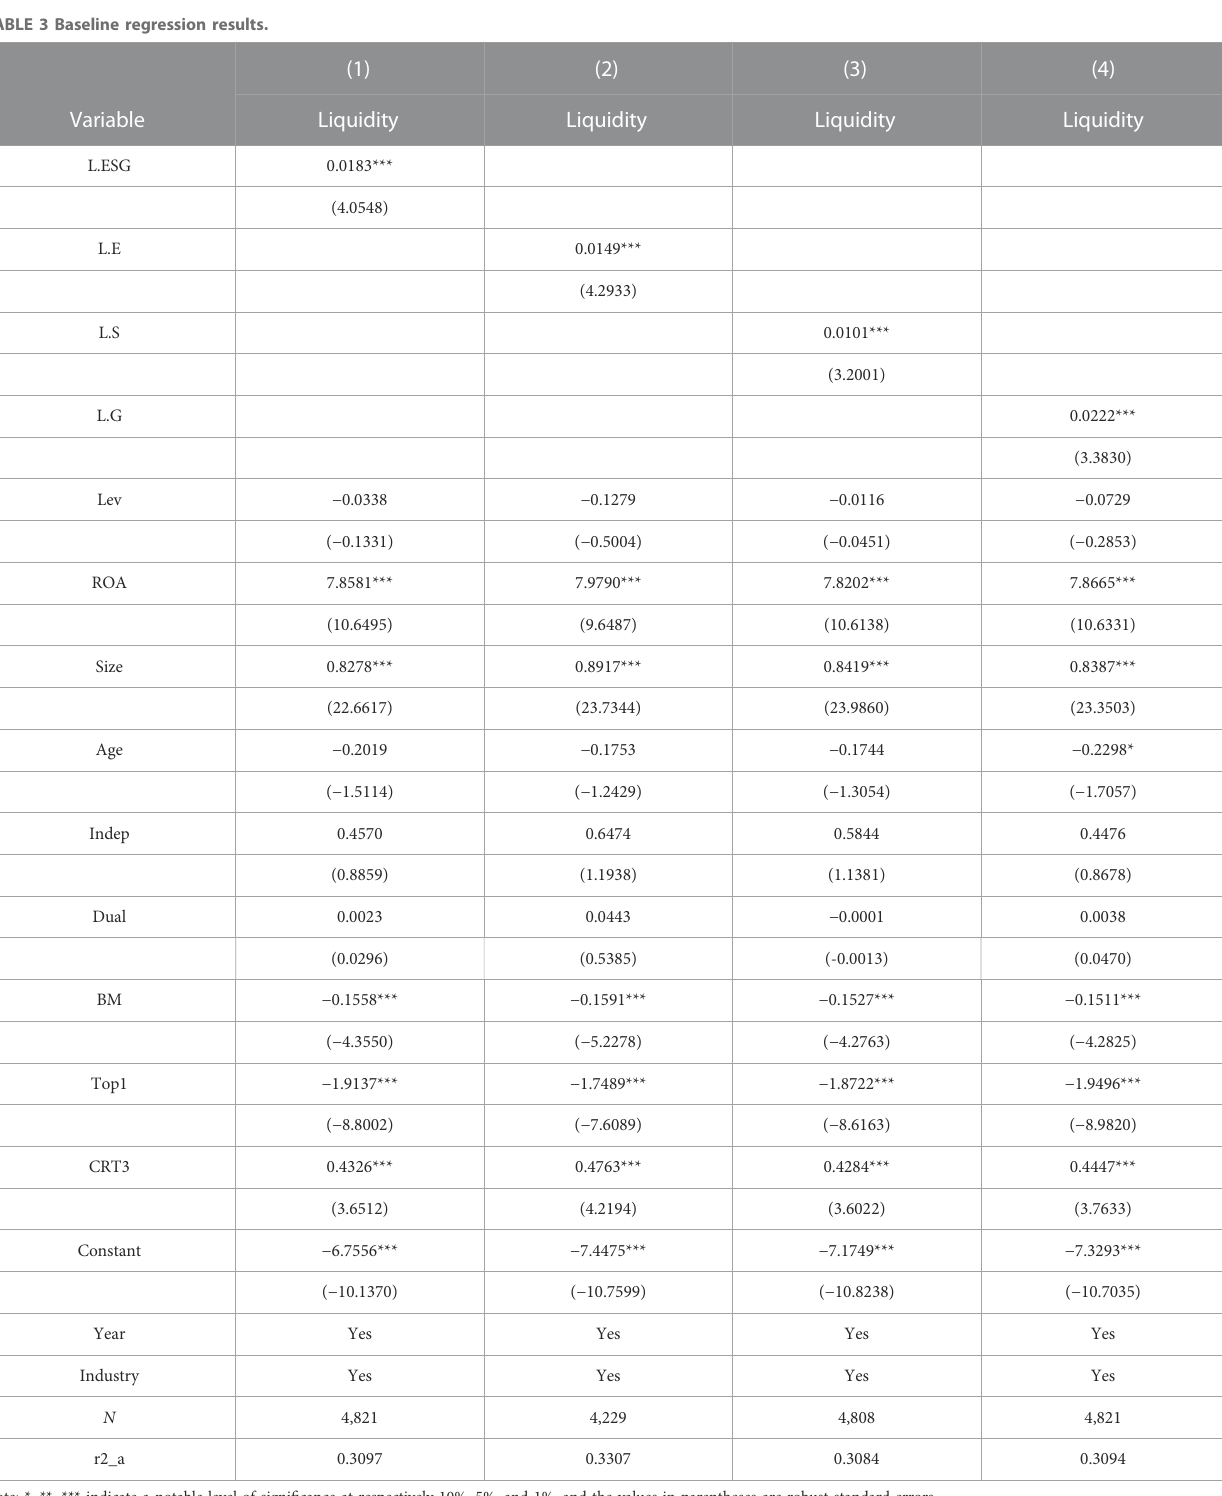
TABLE 3 Baseline regression